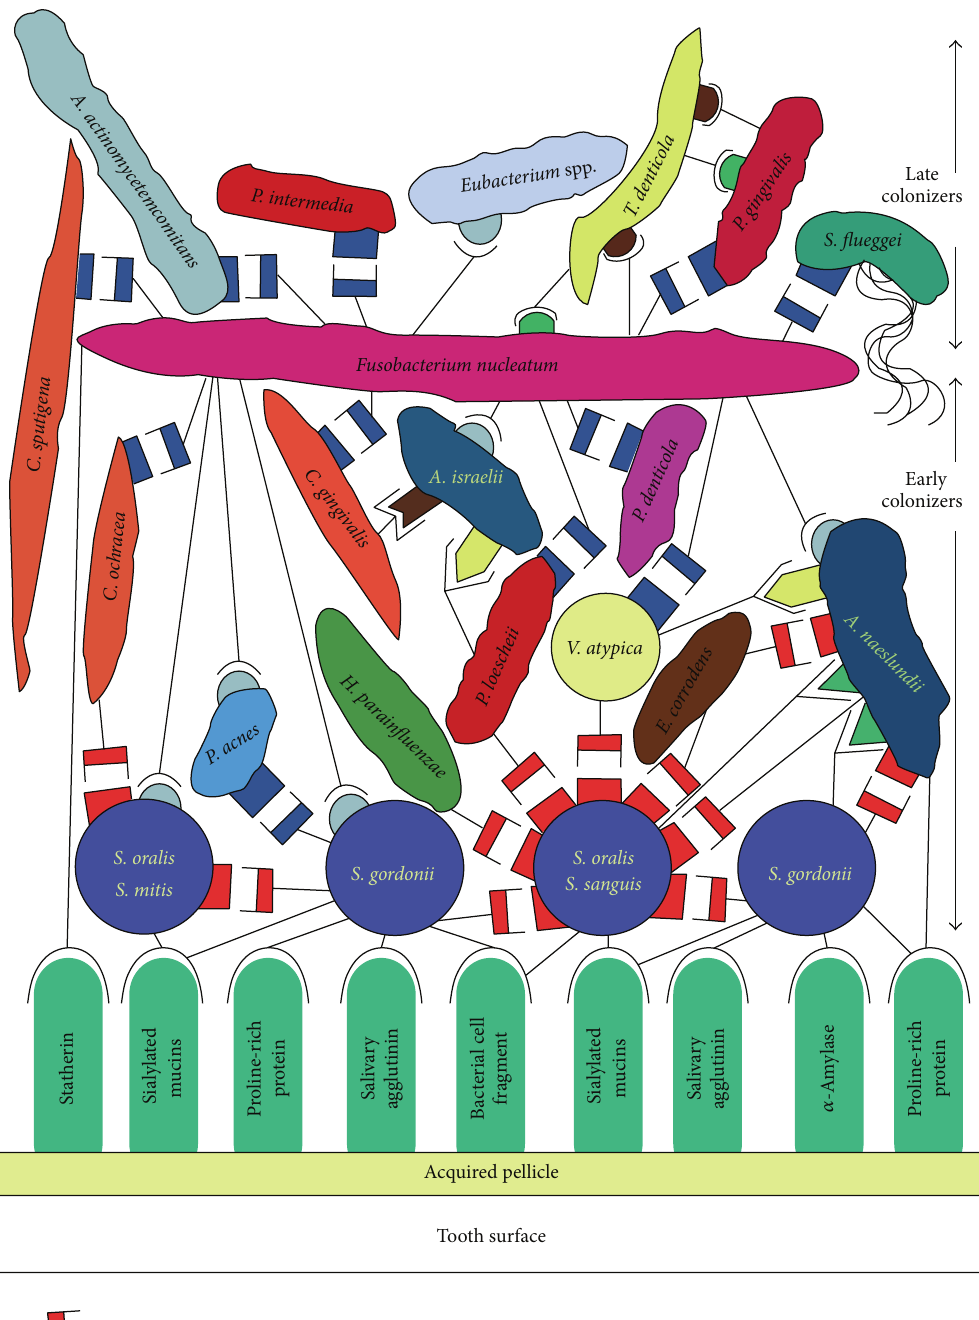
Figure 1: Showing the formation and maturation of dental plaque. (Source [4]